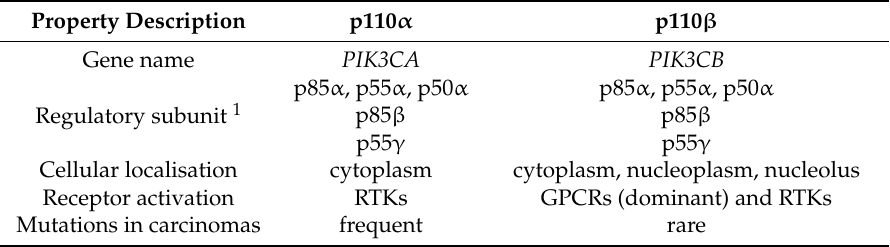
Table 1. Differences and similarities between p110 α and p110 β